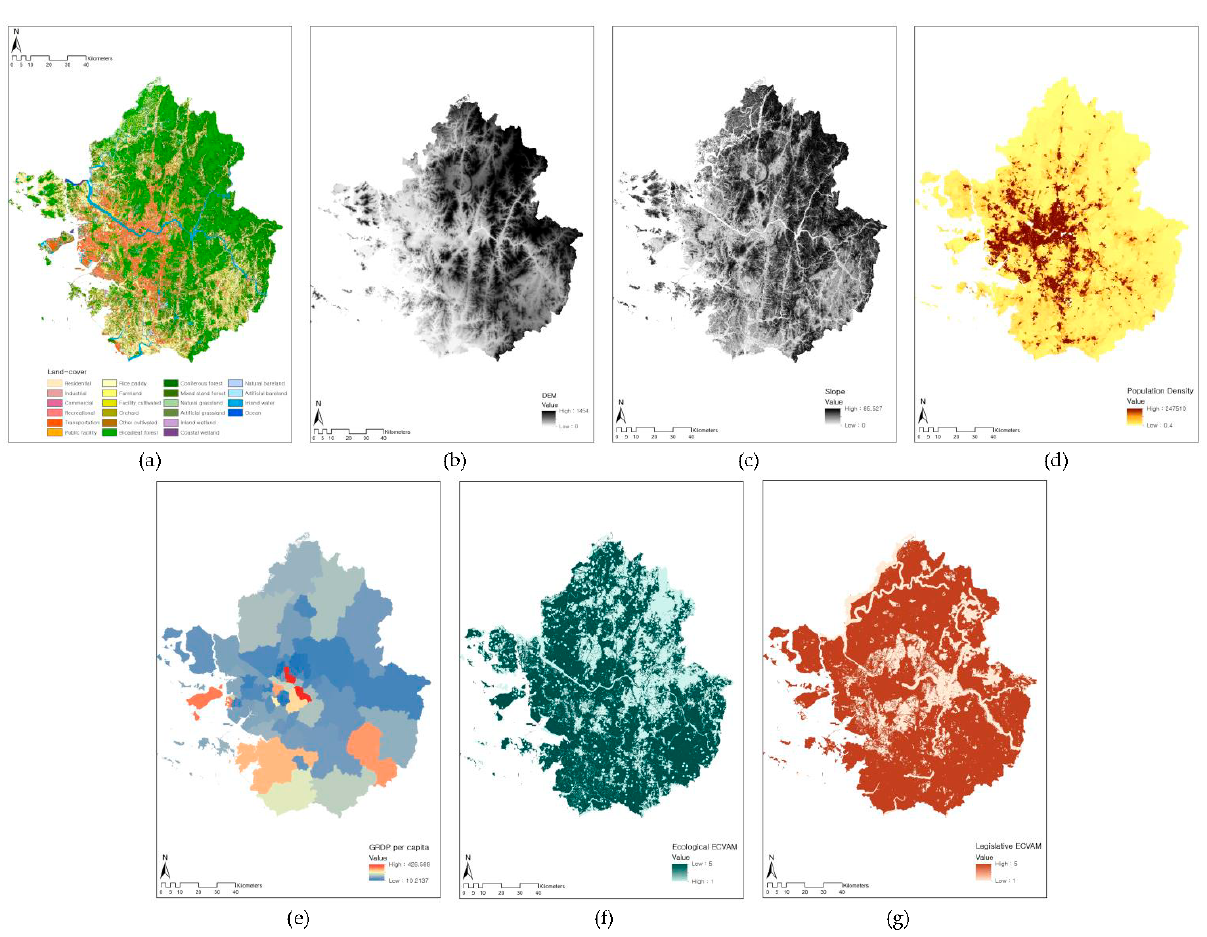
Figure 3. Variables used in the study—( a ) Land-cover, ( b ) Elevation, ( c ) Slope, ( d ) Population density, ( e ) GRDP per capita, ( f ) Ecological ECVAM, ( g ) Legislative ECVAM.